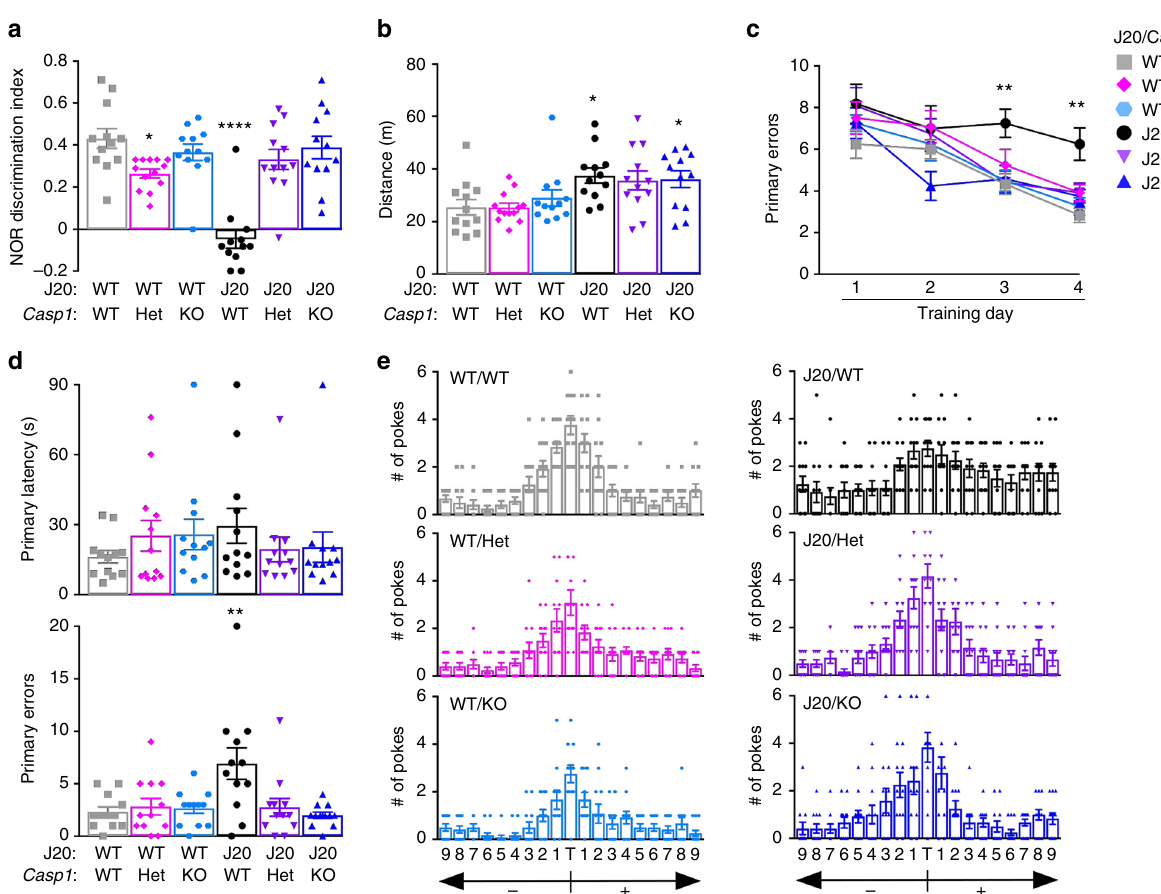
Fig. 3 Casp1 KO restores cognitive function in J20 mice. a − e Genotypes: J20 − / − / Casp1 − / − WT/WT (grey squares), J20 − / − / Casp1 + / − WT/Het (pink diamonds), J20 − / − / Casp1 − / − WT/KO (blue symbol), J20 − / + / Casp1 + / + J20/WT (black circles), J20 − / + / Casp1 − / + J20/Het (purple triangles), J20 − / + / Casp1 − / − J20/KO (blue triangles). Each mouse tested is represented by one symbol. Data represent mean and s.e.m. a NOR discrimination index (F (5,67) = 16.22, p < 0.0001) and b distance travelled during open fi eld task (F(5,67) = 3.717, p = 0.005). c − e Barnes maze: c # of primary errors during learning acquisition (Genotype, F(5,263) = 6.469, p < 0.0001; Training day, F(3,263) = 29.44, p < 0.0001), d probe primary latency and errors (Primary errors, F(5,66) = 4.8, p = 0008) and e target preference. a , b , d ANOVA and c two-way ANOVA, Dunnett ’ s post-hoc versus WT/WT. * p < 0.05, ** p